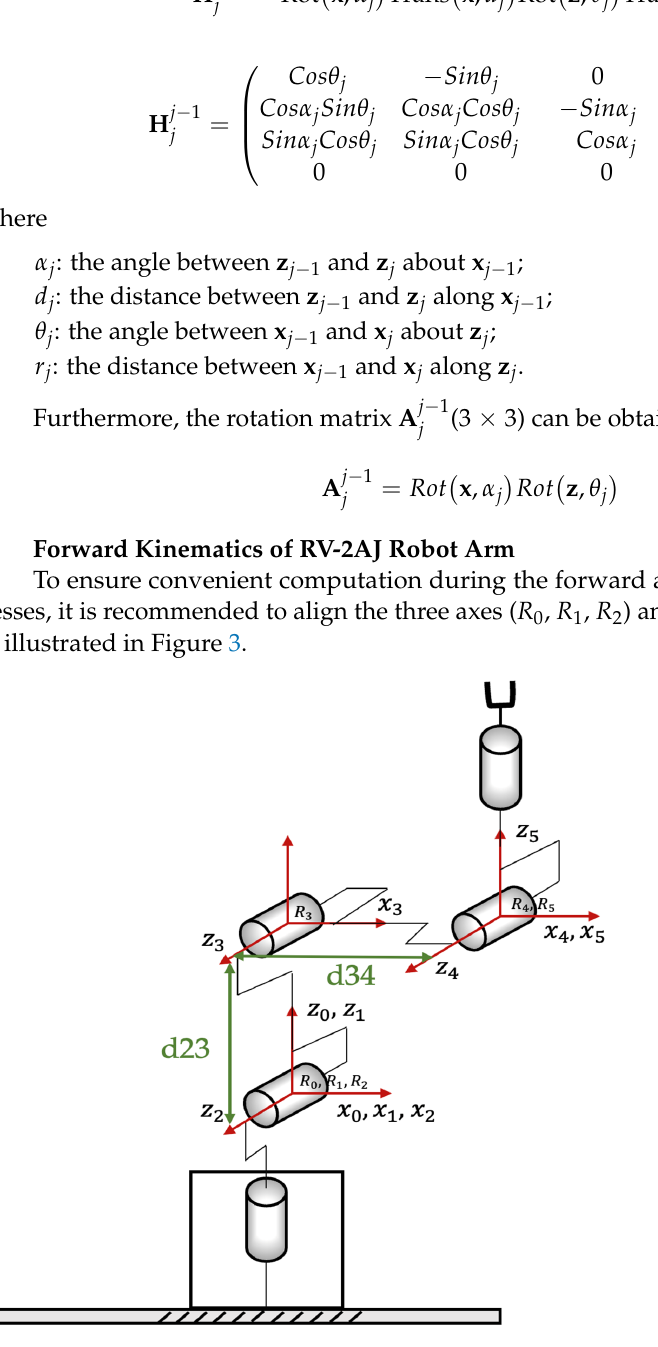
Figure 3. Frame assignments of RV-2AJ robotic arm.